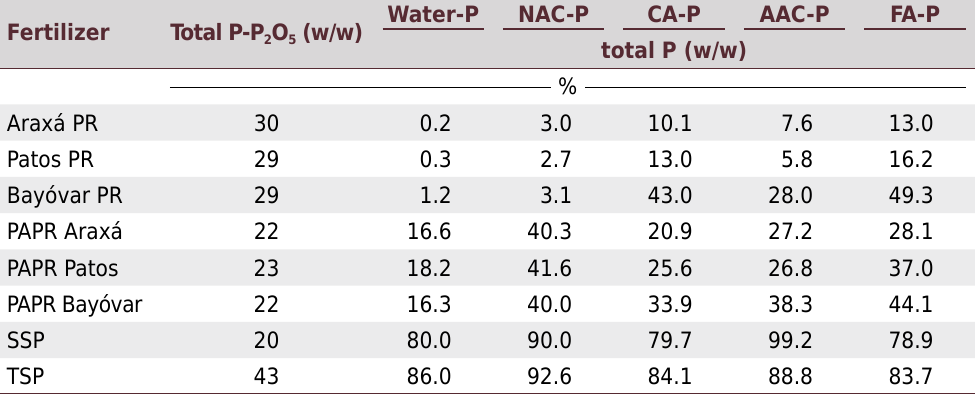
Table 1. Total P content and its soluble portion in water (water-P), neutral ammonium citrate pH 7 (NAC-P), 2 % citric acid (CA-P), acid ammonium citrate pH 3 (AAC-P), and 2 % formic acid (AF-P) Fertilizer